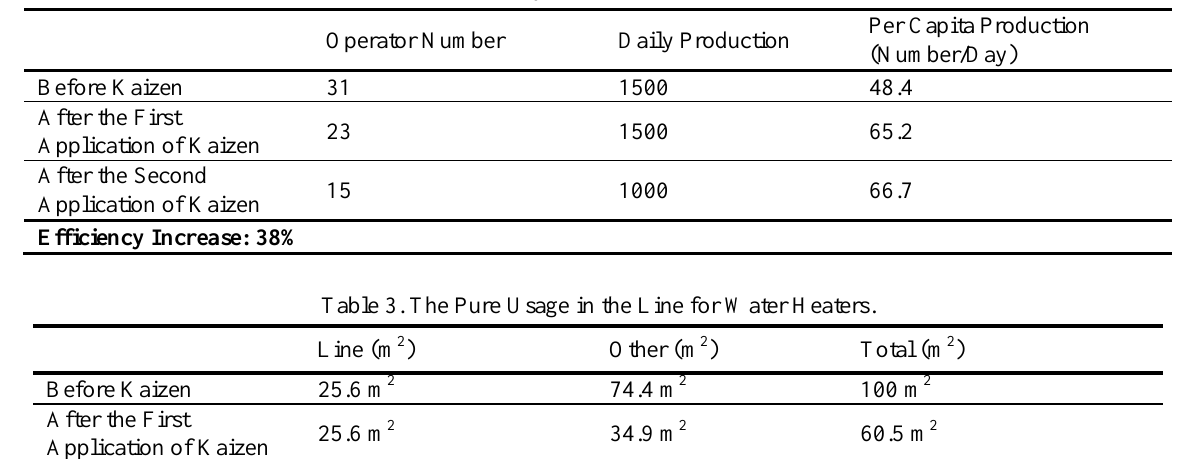
Table 2. The Efficiency in the Line for the Water Heaters.